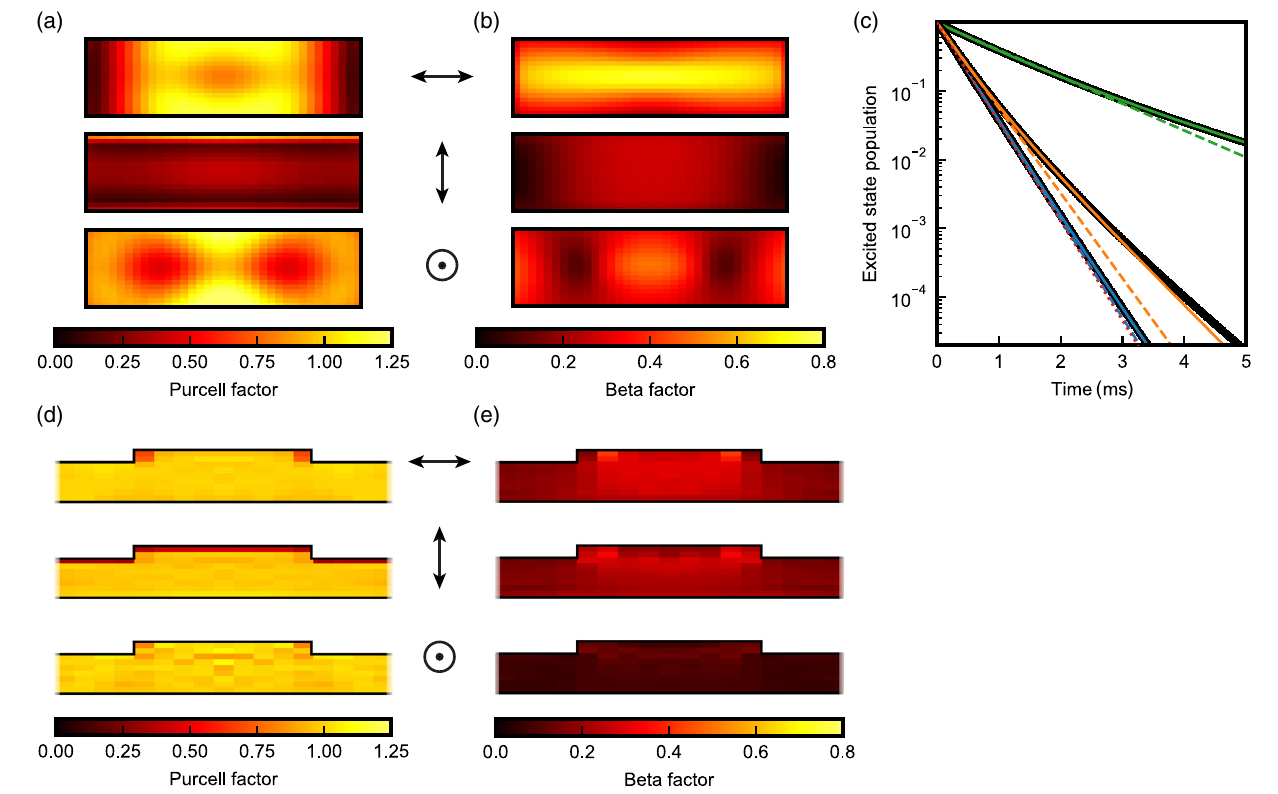
FIG. 14. Modification of the electric-dipole emission in the different samples. Finite-difference-time-domain calculations are used to simulate the photonic density of states depending on the position in the waveguide (cross-sectional images) and the orientation of the electric dipole (black symbols). From this, the emission rate of erbium dopants is determined. In addition, the probability β to emit into the guided mode is calculated. The dimensions of the waveguides differ between samples, as shown in Fig. 1. (a,b) Ridge waveguides used on the CVD and CZ samples. The decay rate can be increased (Purcell enhancement F P > 1 ) or reduced ( F P < 1 ) depending on the position. Here, β approaches unity for erbium dopants at the waveguide center with a horizontal dipole orientation (top), but it is much smaller for the other dipole orientations. (c) Expected temporal decay of the fluorescence in the ridge waveguides. A Monte Carlo simulation is performed, in which dopants are randomly positioned in the waveguide according to the implantation profile. Then, their dipole decay is averaged, weighted by the β factor. The resulting data for different dipole orientations (black line) deviate from a single exponential fit (dashed line). A biexponential decay (solid line) gives better agreement. (d,e) Rib waveguides used on the FZ samples. The Purcell factor is F P ¼ 1 , almost independent of the position in the waveguide. Thus, one expects a decay with a time constant that is independent of the emitter orientation and that matches the lifetime of the dopants in bulk crystals. The average β factor is much lower than in the ridge waveguide geometry, and mostly light of transversal polarization (top and center panels) is emitted into the guided